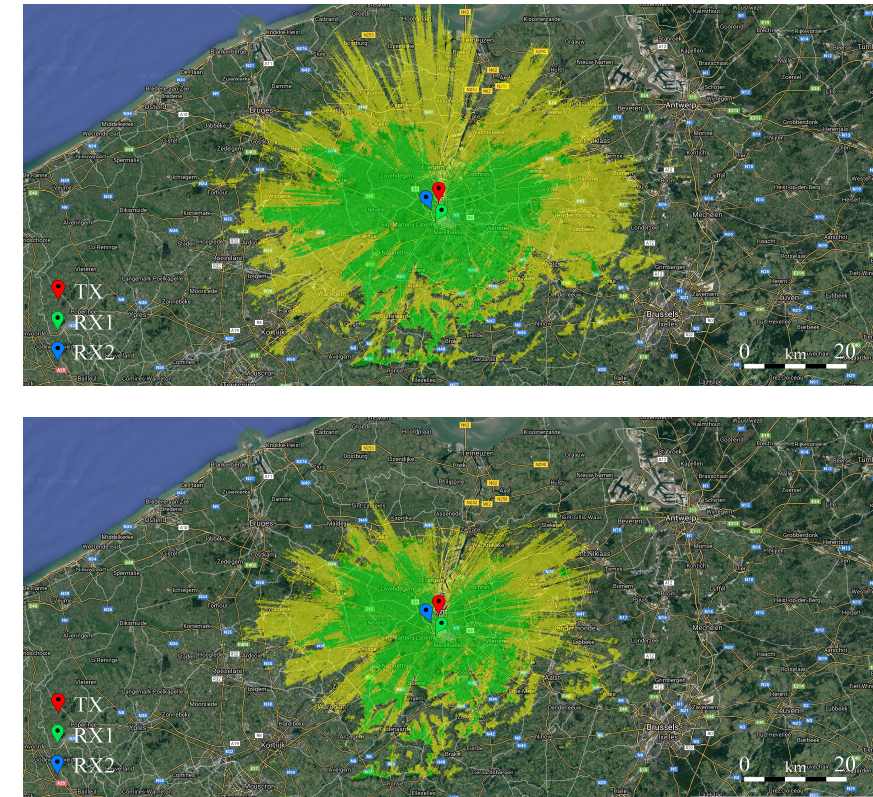
Figure 9. Simulation-based coverage maps for the 434MHz ( upper map ) and 902MHz ( lower map ) bands for the transmitter described in Section 3.1. Yellow areas denote the coverage with a reception threshold of − 136dBm and green areas denote the coverage with a link budget that is 10dB greater than this threshold. Maps generated using Radio Mobile RF by Roger Coudé